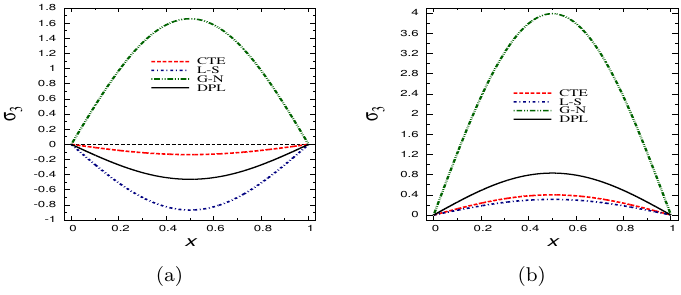
Figure 10. The transverse normal stress distributions in the axial direction for beams under (a) thermal load and (b) thermomechanical load.